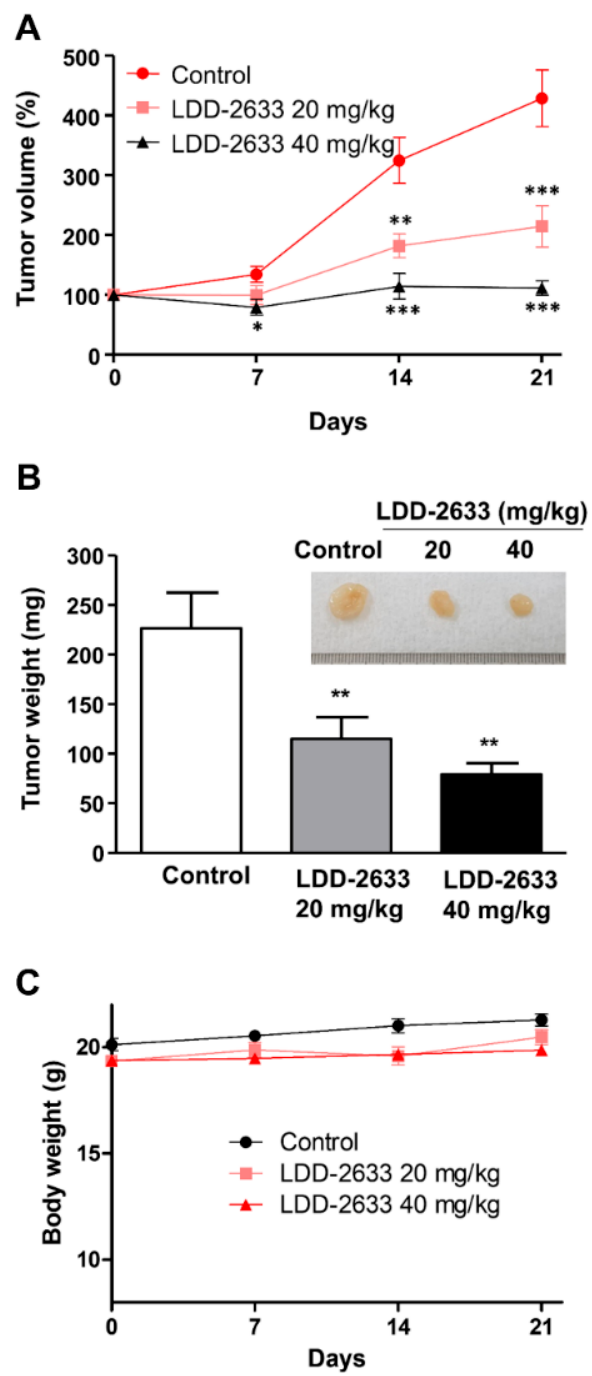
Figure 4. In vivo anti-tumor efficacy of LDD-2633. Tumor xenografts were generated by inoculating TT cells into BALB/c nu/nu mice, and the tumors were allowed to grow to the size of 100 mm 3 ( n = 8). LDD-2633 (20 or 40 mg/kg) or PBS control was administered to the mice by oral gavage for 21 days. ( A ) The tumor size was measured for the indicated time after starting drug administration. Tumor volume was calculated using the following formula: V (volume) = X (length) × D (width) 2 /2. ( B ) Tumor xenografts were isolated and tumor weights were measured on day 21. Representative photographic images of tumors are shown in the inset. ( C ) Mice body weights were measured at the indicated time. Results represent the means ± standard errors of mean. The symbols *, **, and *** indicate p < 0.05, p < 0.01, and p < 0.001, respectively.